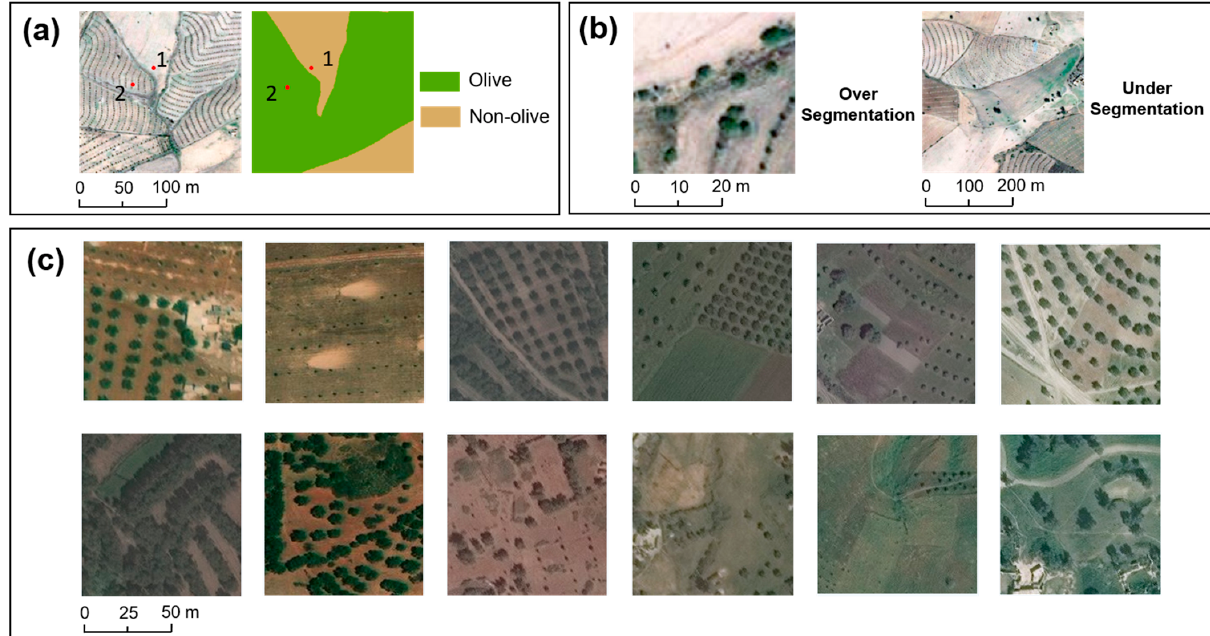
Figure 3. ( a ) Pixel-based classification can be problematic in VHR imagery. For example, points 1 and 2 are two soil pixels having similar features but belong to two classes, which make it challenging for pixel-based classification to distinguish the two; ( b ) over-segmentation (i.e., with too limited spatial information to represent the target object) and under-segmentation (i.e., with too much information that will obscure the target object); ( c ) olive patches and non-olive patches of varying morphology (first row: olive, second row: non-olive).